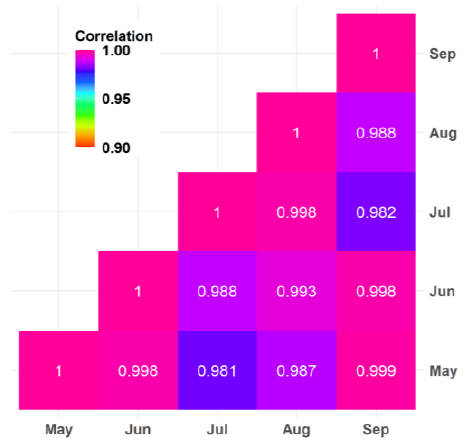
Figure 6. Correlation coefficient of monthly cooling energy.